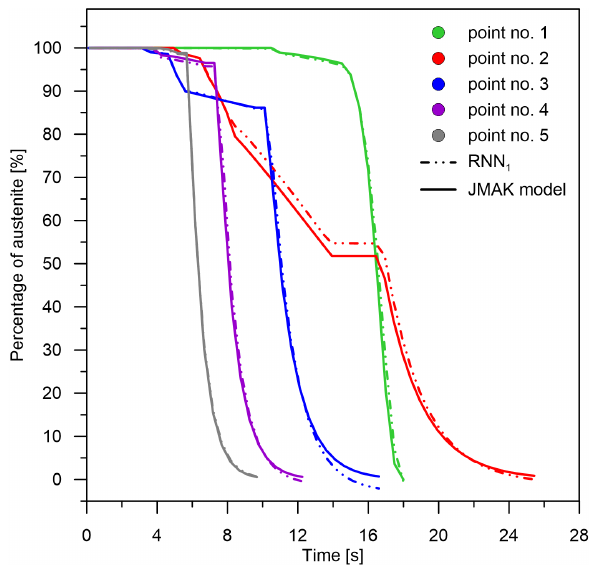
Figure 5. Kinetics of austenite transformation for selected points—consideration of weights in initial learning. Comparison of data calculated by the JMAK numerical model and data determined by the RNN.